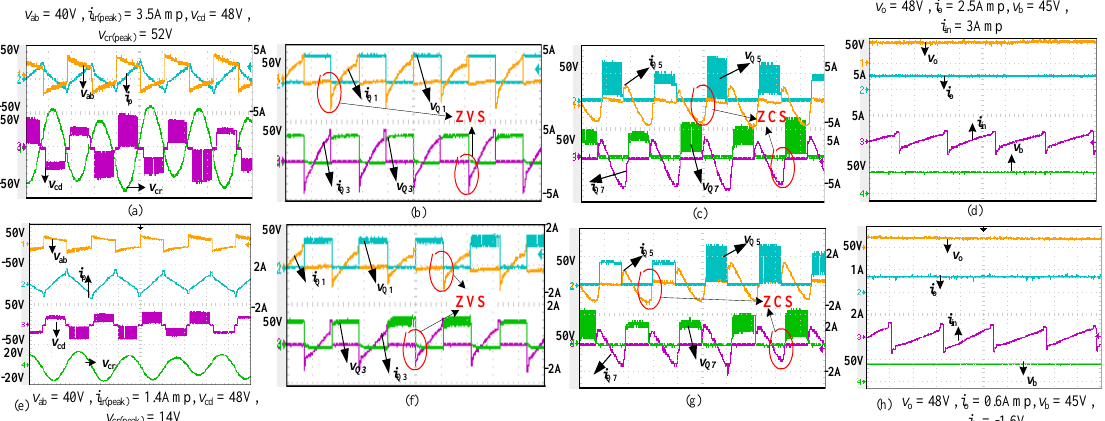
Figure 12. Forward Mode Case 1: At full load ( a ) Waveforms of v ab , i p , v cd, and v cr ( b ) waveforms showing ZVS for switches Q 1 & Q 3 ( c ) waveforms showing ZCS for switches Q 5 & Q 7 ( d ) Waveforms of v o , i o , v b , and i dis ; Case 2: ( e ) Waveforms of v ab , i p , v cd and v cr ( f ) waveforms showing ZVS for switches Q 1 & Q 3 ( g ) waveforms showing ZCS for switches Q 5 & Q 7 ( h ) Waveforms of v o , v b , i o and i s .